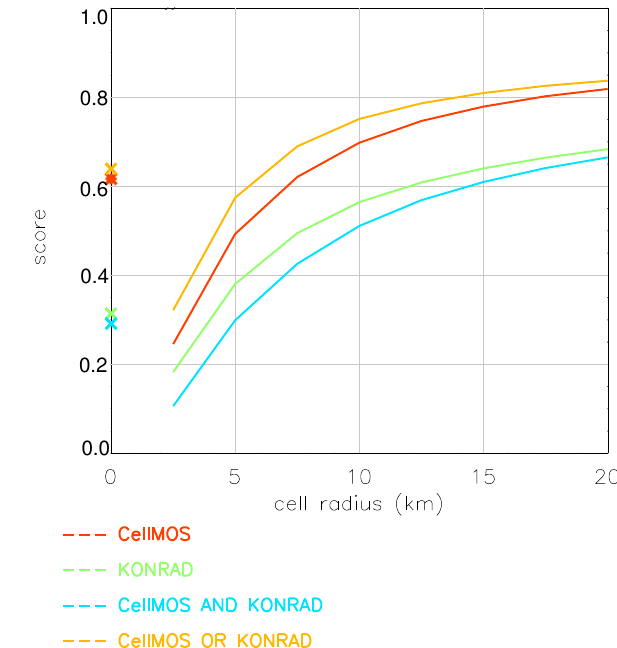
Figure 2. Pointwise approach. Probability of detection (percentage of hits of all observed events, 772347) of lightning strokes that oc- curred (summer 2010) within the given radius of cells detected by CellMOS, KONRAD, CellMOS and KONRAD, CellMOS or KON- RAD analysis. The crosses indicate the results using the cell radius given by the algorithm.